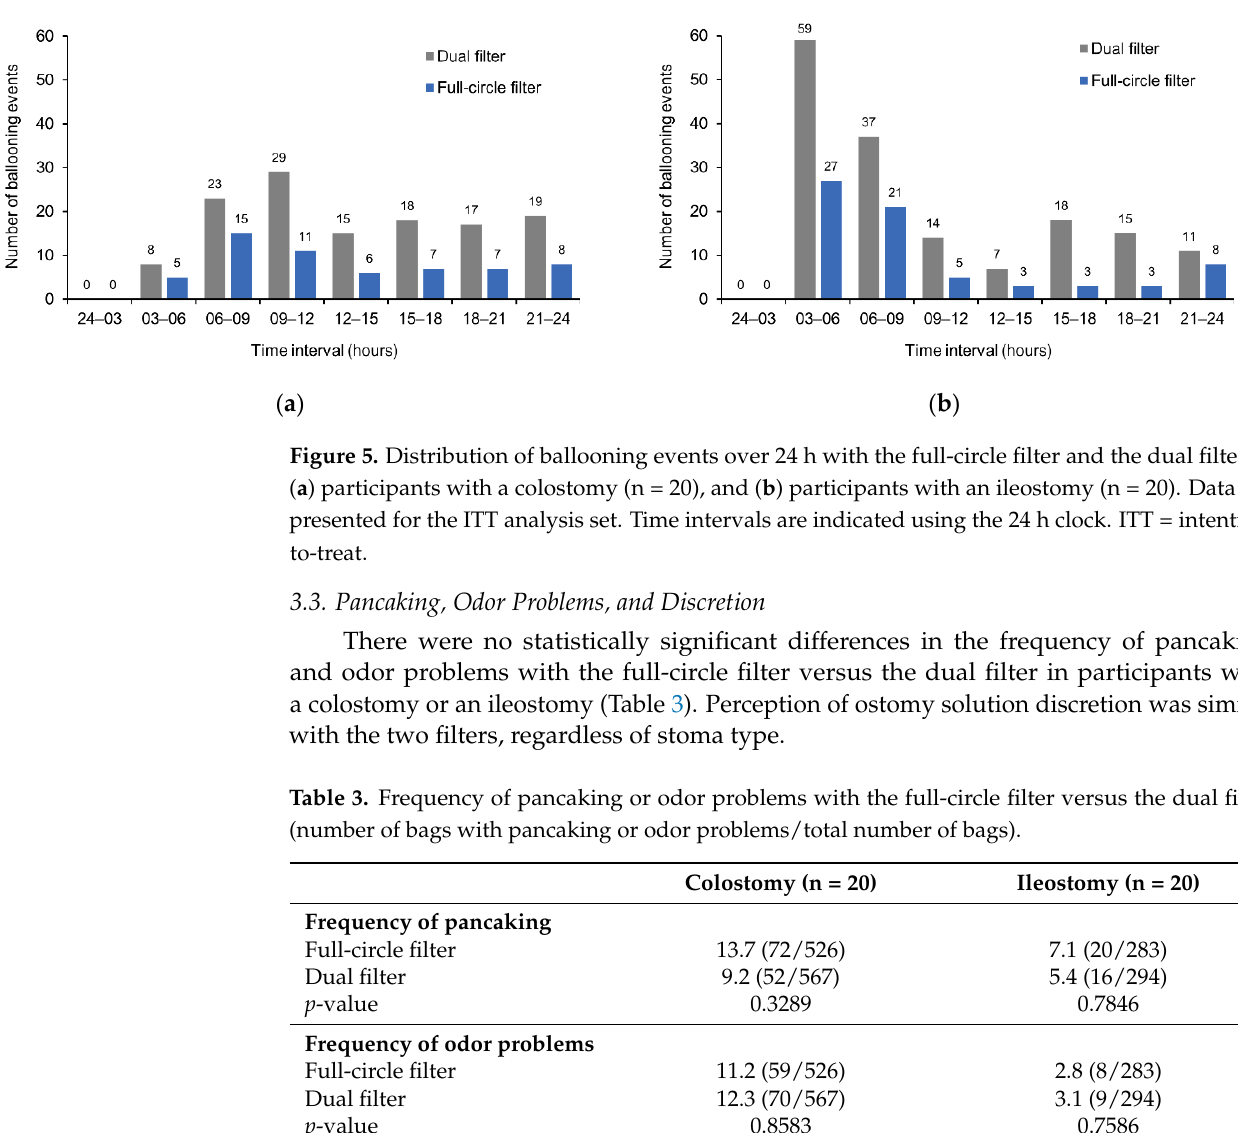
8 of 12 Table 2. Number of ballooning events per person with the full-circle filter versus the dual filter. Colostomy (n = 20) Ileostomy (n = 20) Ballooning events per person Full-circle filter